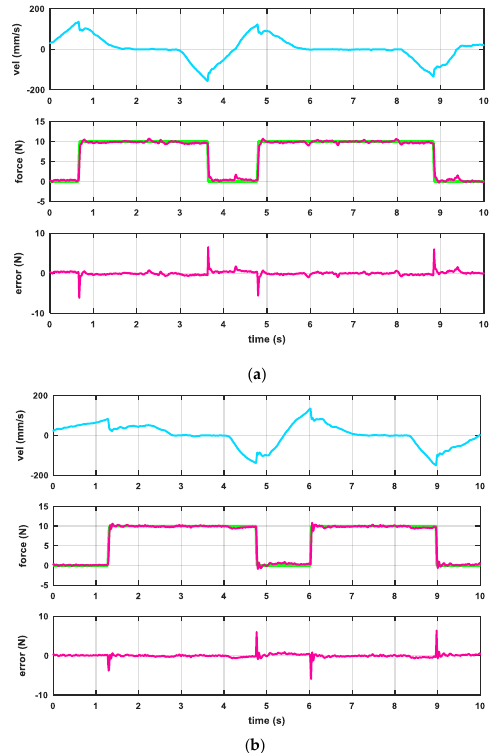
Figure 12. The control response at the CRF (